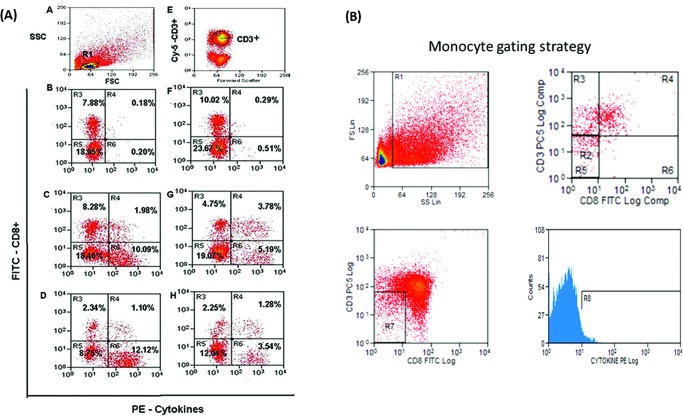
Flow cytometric evaluation. (A) T. cruzi-stimulated cells. Lymphocytes in the R1 region based on the SSC/FSC (Side Scatter/Forward Scatter) ratio; (E) CD3 surface marker staining on lymphocytes gated in R1; (B, C, D, F, G, H) CD8 surface- and intracellular IFN-γ-stained cells were simultaneously gated in R1 (lymphocytes) and R2 (CD3+ cells). R3 and R5 regions represent CD8+ and CD8- (i.e.: CD4+) cells negative for IFN-γ, respectively; R4 and R6 represent CD8+IFN-γ+ and CD4+IFN-γ+ cells, respectively. Peripheral blood mononuclear cells were cultured for 72 h without T. cruzi antigen (B, C, D) and with T. cruzi antigen (F, G, H) and subsequently exposed to PMA, ionomycin, and brefeldin A (BFA) for the last 4 h. For each analysis, approximately 50,000 events were acquired on a FACSCalibur flow cytometer. (B) Monocyte gate strategy. Flow cytometric acquisition and subsequent analysis were manually performed within a monocyte gate defined for each sample using CellQuest (BD Bioscience, Immunocytometry System) based on a higher FSC/SSC ratio and negative expression of CD3 and CD8 (R7 region) and are displayed as histograms showing cytokines (PE) (R8 region).